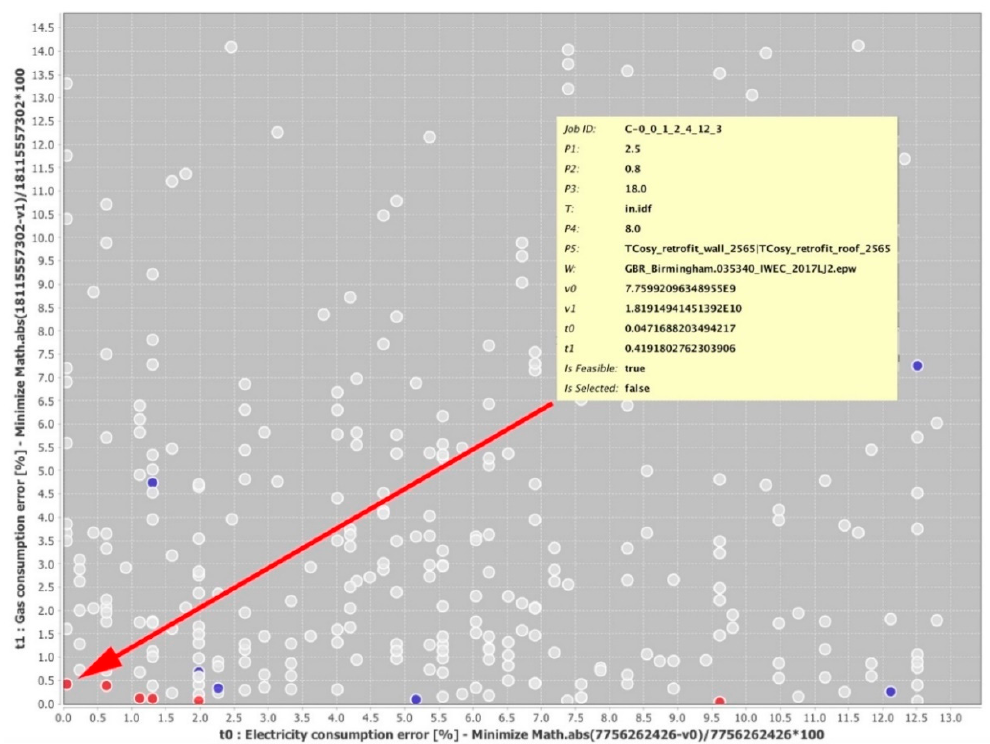
Figure 2. Scatter plot of calibration of the existing building used for the simulated dynamic heating test.